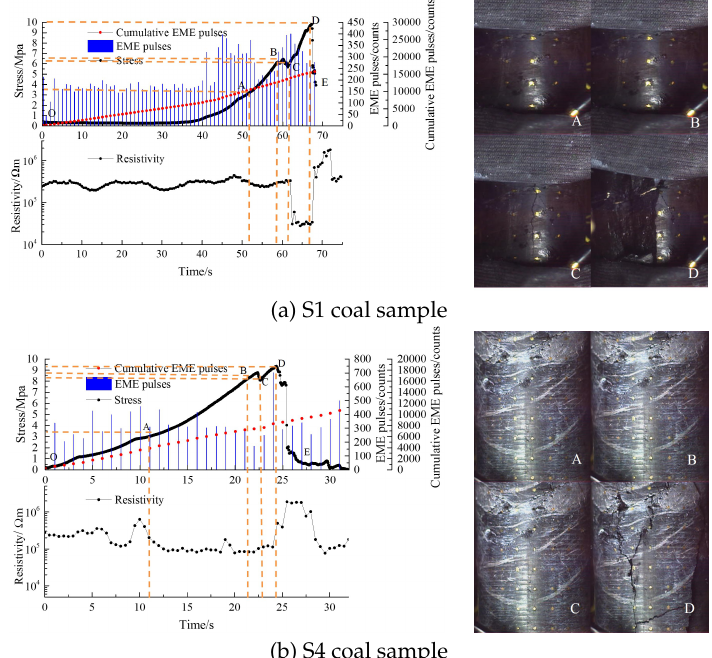
Fig. 4. Resistivity, electromagnetic radiation and crack propagation characteristics of Shadunzi samples (A,B,C,D represents the different stress loading points of coal samples and the deformation and fracture diagrams of coal under the corresponding stress loading